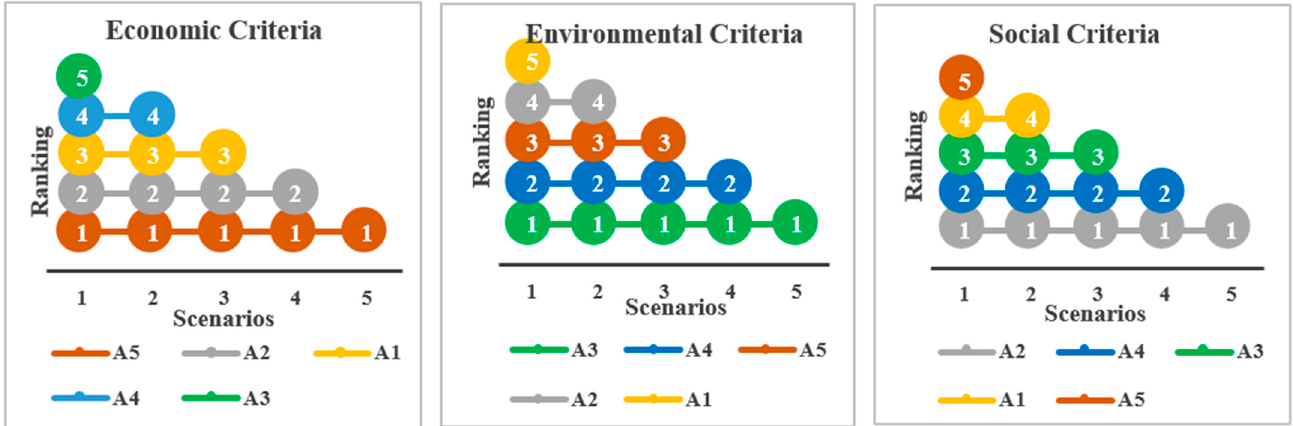
Figure 9. The new alternative ranks in the dynamic decision matrix.